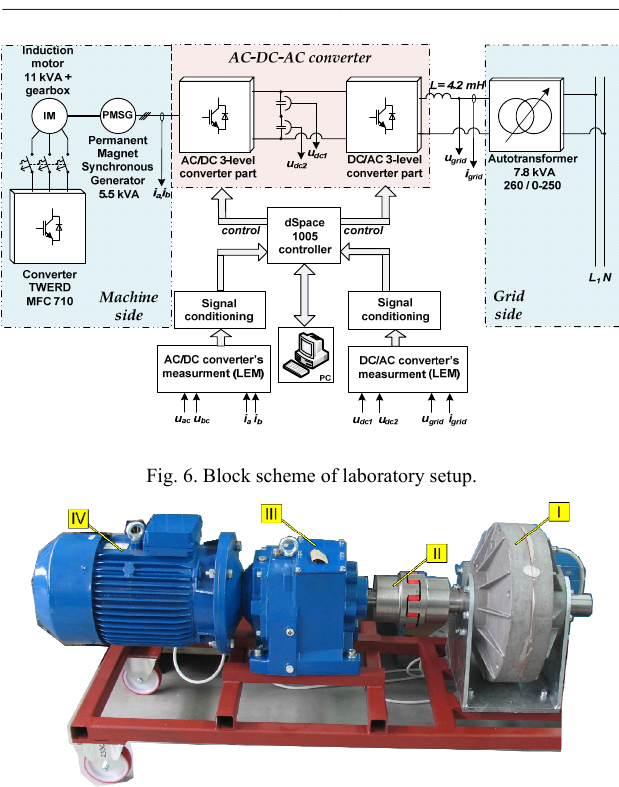
Fig. 7. PMSG based wind turbine laboratory model: I – low speed PMSG, II –clutch, III – gearbox, IV – high speed induction motor.